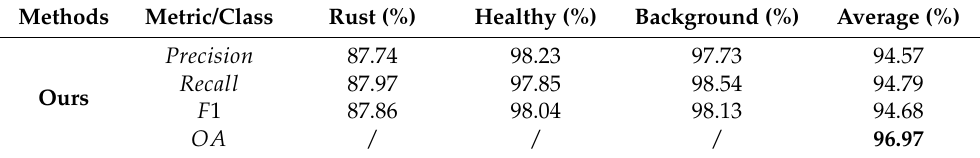
Table 9. Performance with inputs D.